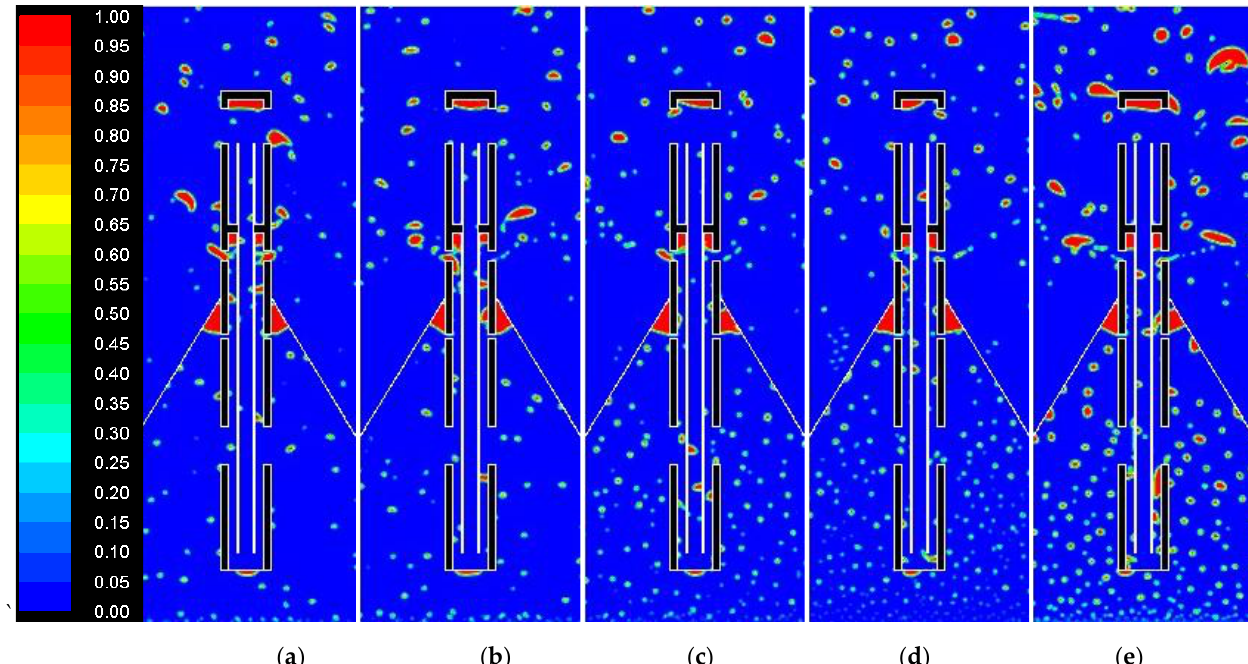
Figure 4. Cloud diagram of gas-phase distribution at gas holdup 5% when total flow is at ( a ) 20 m 3 /d; ( b ) 30 m 3 /d; ( c ) 40m 3 /d; ( d ) 50 m 3 /d; ( e ) 60 m 3 /d.